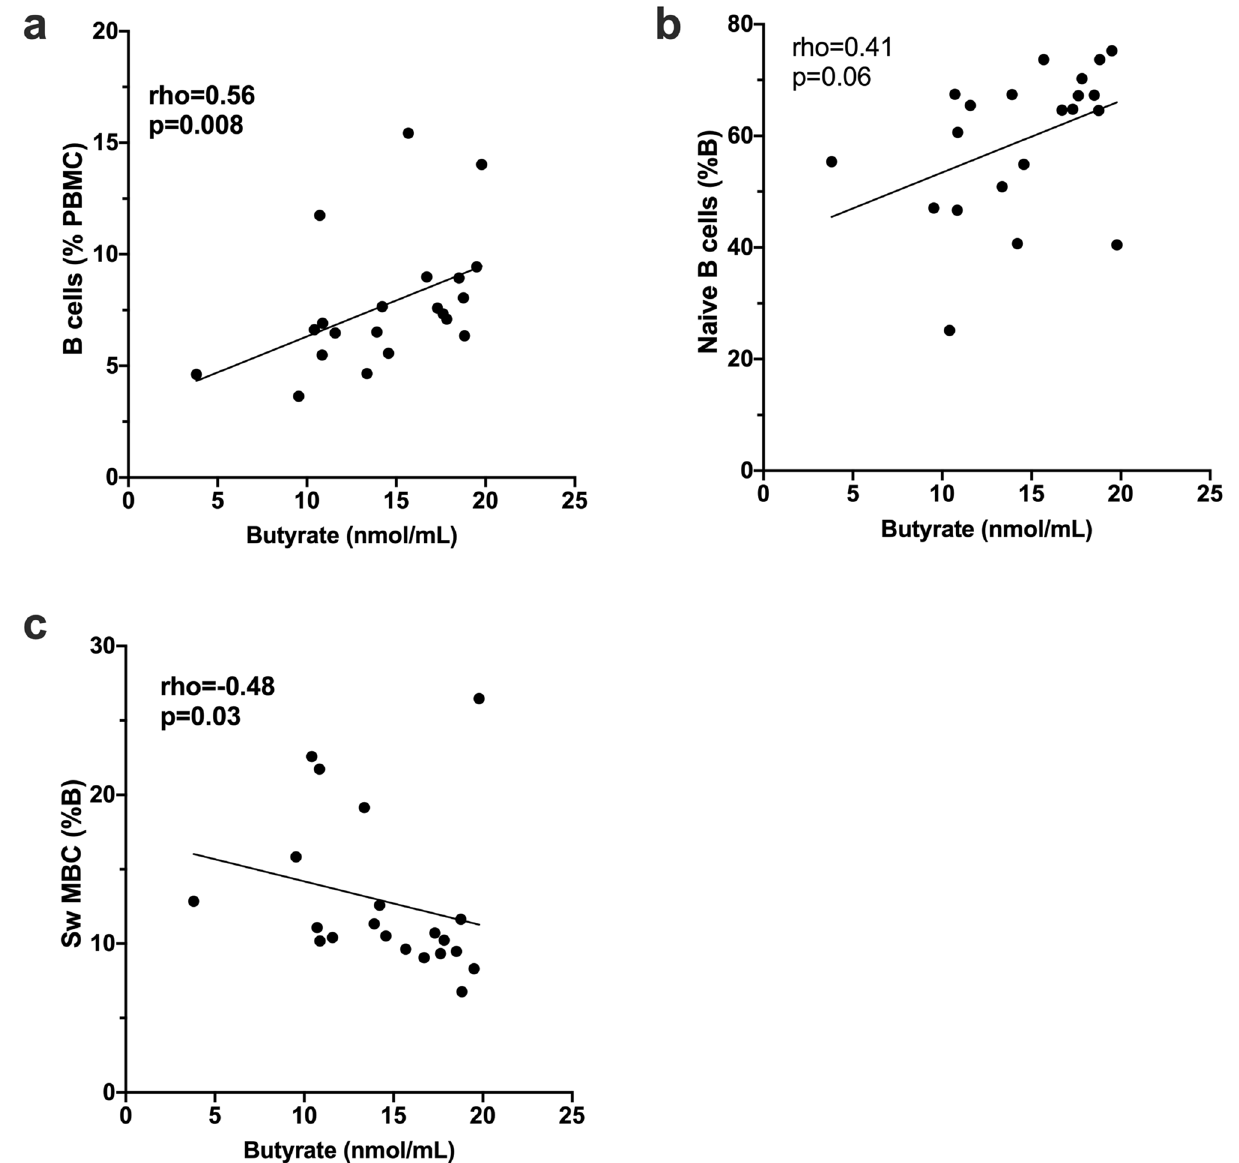
isolated from 21 CIS/MS patients. Correlation was tested using nonparametric Spearman correlation; rho and p values are shown. Line of regression is shown for illustrative purposes only. Statistically significant p values are shown in bolded